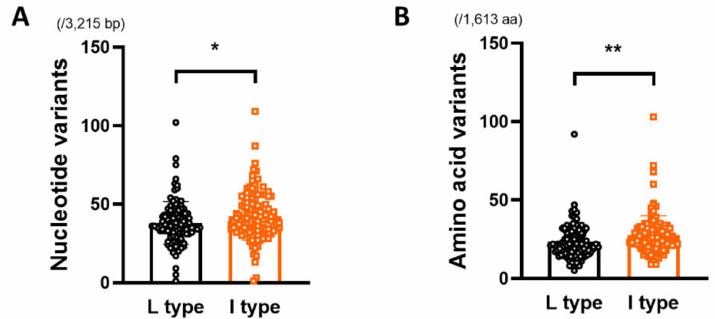
Figure 2. Comparison of genetic diversity of the HBV full genome between rt269L and rt269I. Comparison of the number of ( A ) nucleotide and ( B ) amino acid variants within the HBV full genome between rt269L and rt269I. Significant differences (* p < 0.05, ** p < 0.01) analyzed by independent samples t -test between the groups are shown in the related figures. The bar plot data are presented as the mean ± s.e.m. of each